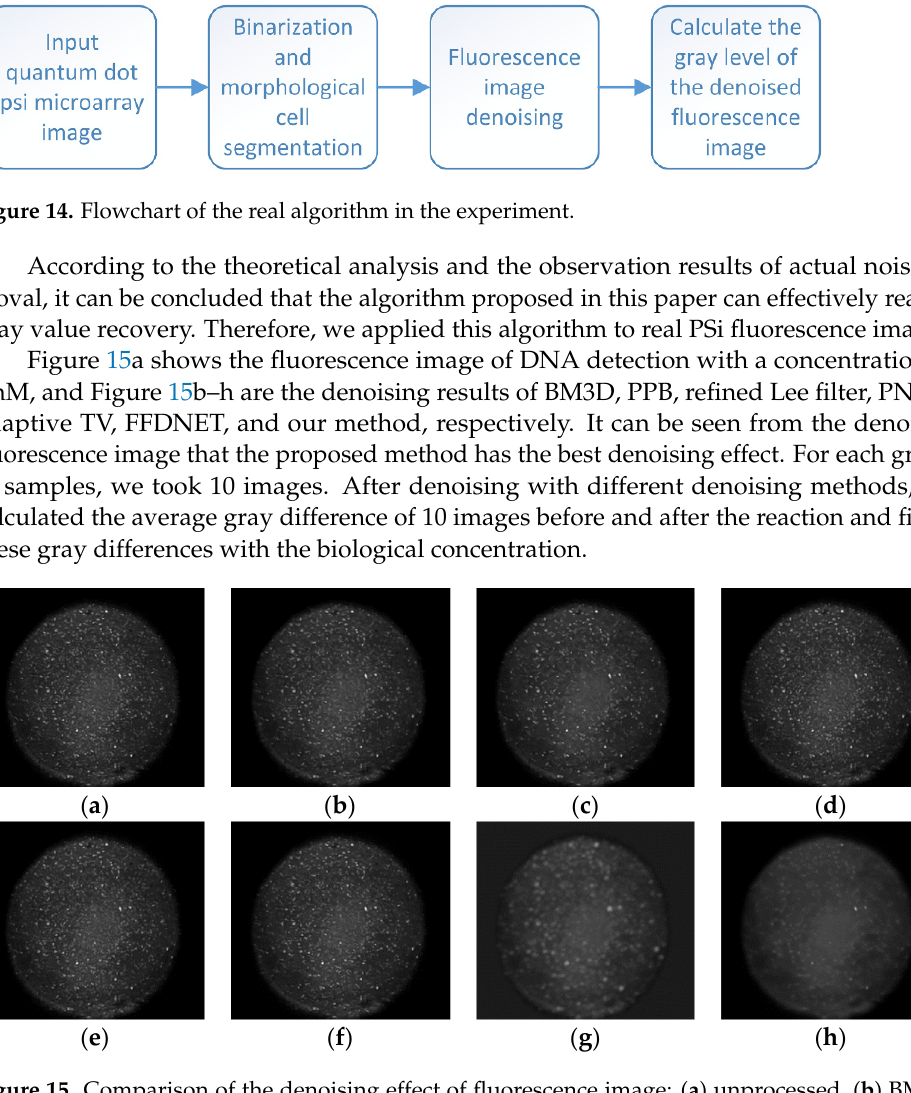
Figure 15. Comparison of the denoising effect of fluorescence image: ( a ) unprocessed, ( b ) BM3D, ( c ) PPB, ( d ) Refined Lee, ( e ) PNLM, ( f ) Adaptive TV, ( g ) FFDNET, and ( h ) proposed.